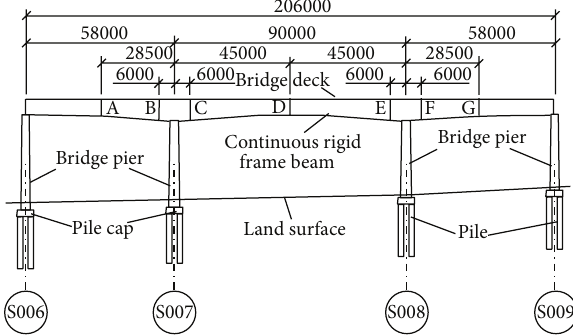
Figure 6: Continuous rigid-frame bridge model.